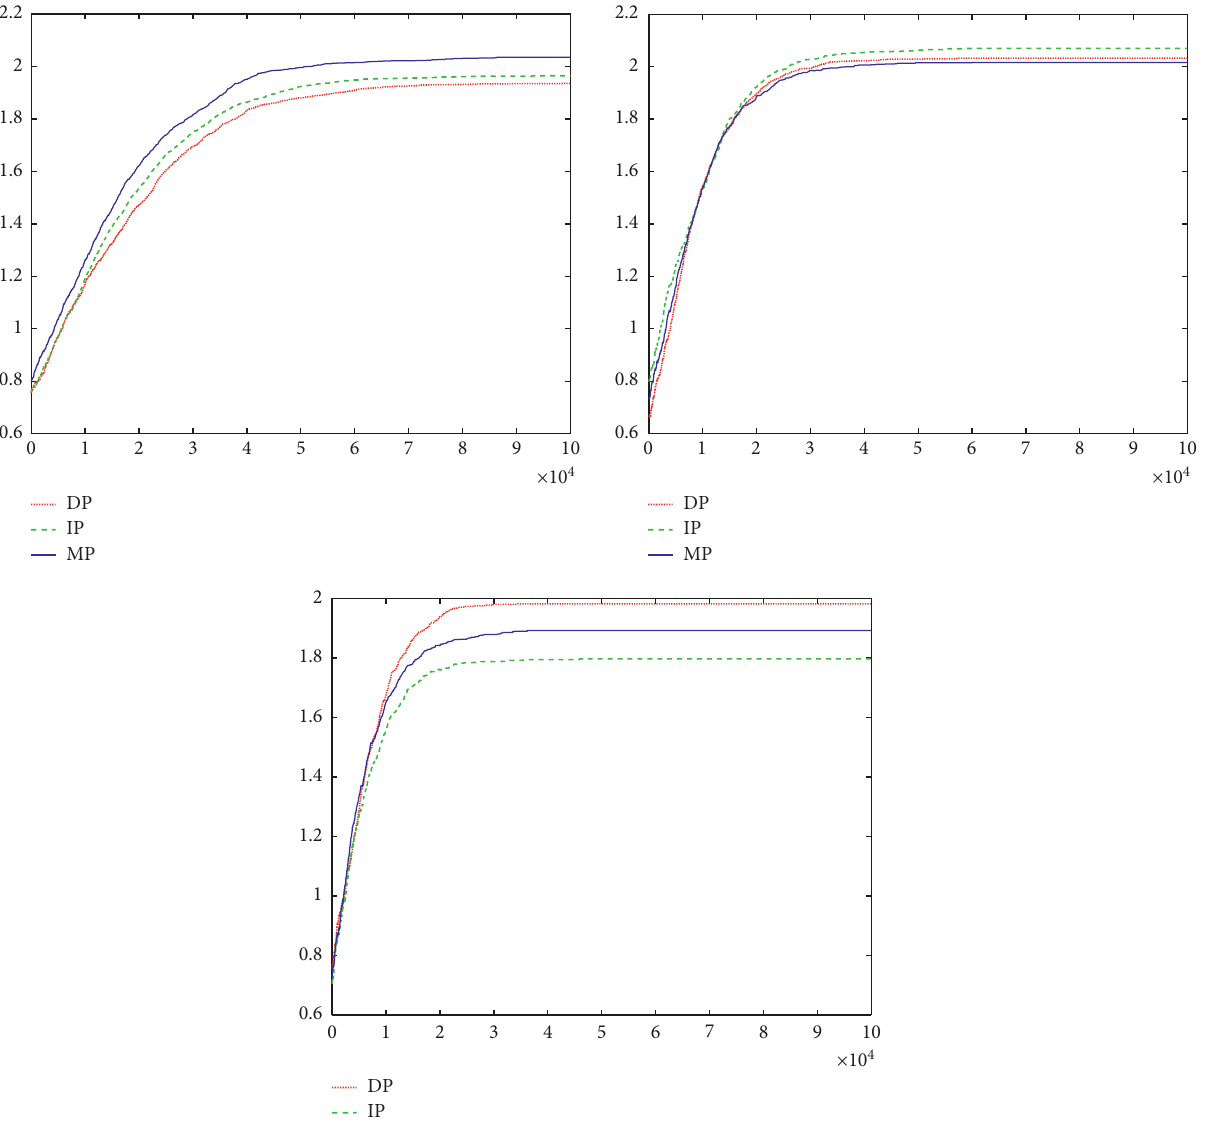
Figure 9: Knowledge equilibrium in a small-world network when k � 2, 4, and